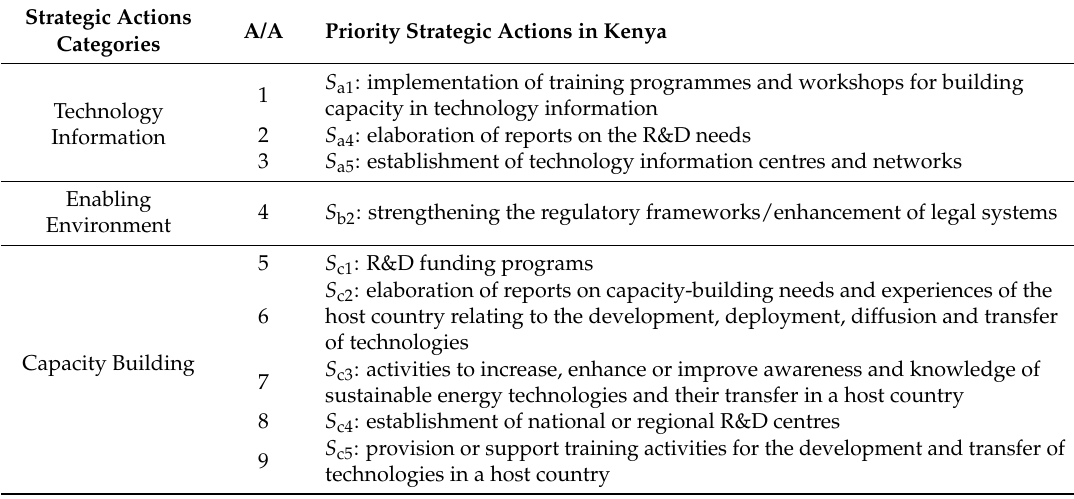
Table 6. Priority strategic actions for the promotion of technology transfer in